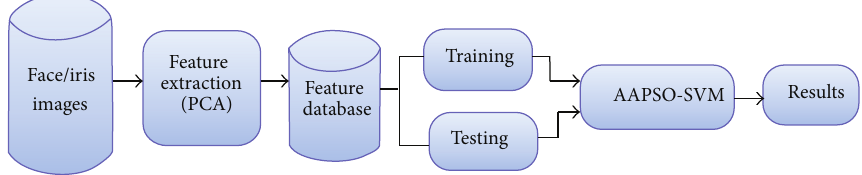
Figure 1: Structure of the proposed recognition technique based on